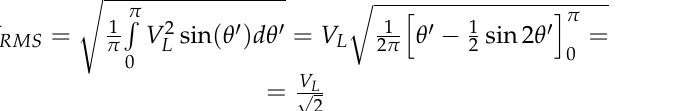
Equation (15) is substituted in (21):